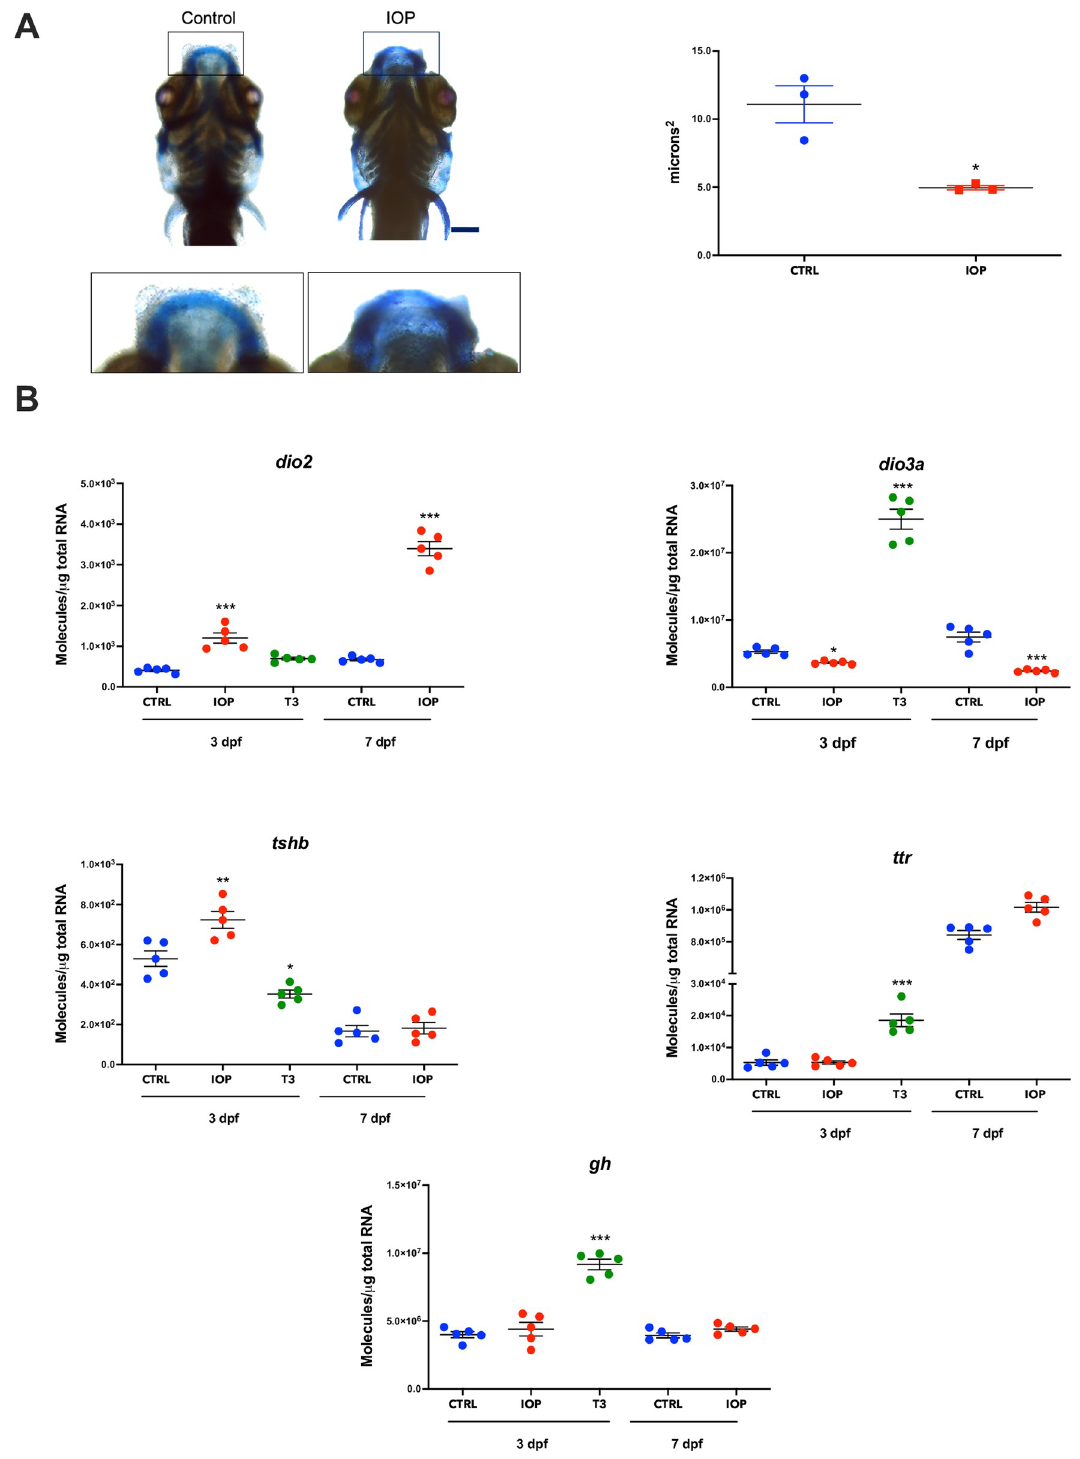
Fig 1. Effects of IOP treatment on thyroid status. ( A ) Effect of IOP on Meckel´s cartilage morphology. Left: Representative image of Alcian blue staining of 7 dpf control zebrafish (left) and IOP-treated (right) larvae. Scale bar 100 μ m. Right: Graph depicting the quantification of Meckel’s cartilage (n = 3 larvae per group). The difference is best visible in the top middle where the stained area is thinner and more faint in the IOP animal. Scale bar 100 μ m. Statistical analysis was performed with a Student’s t test, � p < 0.01 ( B ) Changes in expression of TH-regulated genes in zebrafish larvae exposed to IOP. mRNA quantification of dio2 , dio3 , tshb , ttr and gh